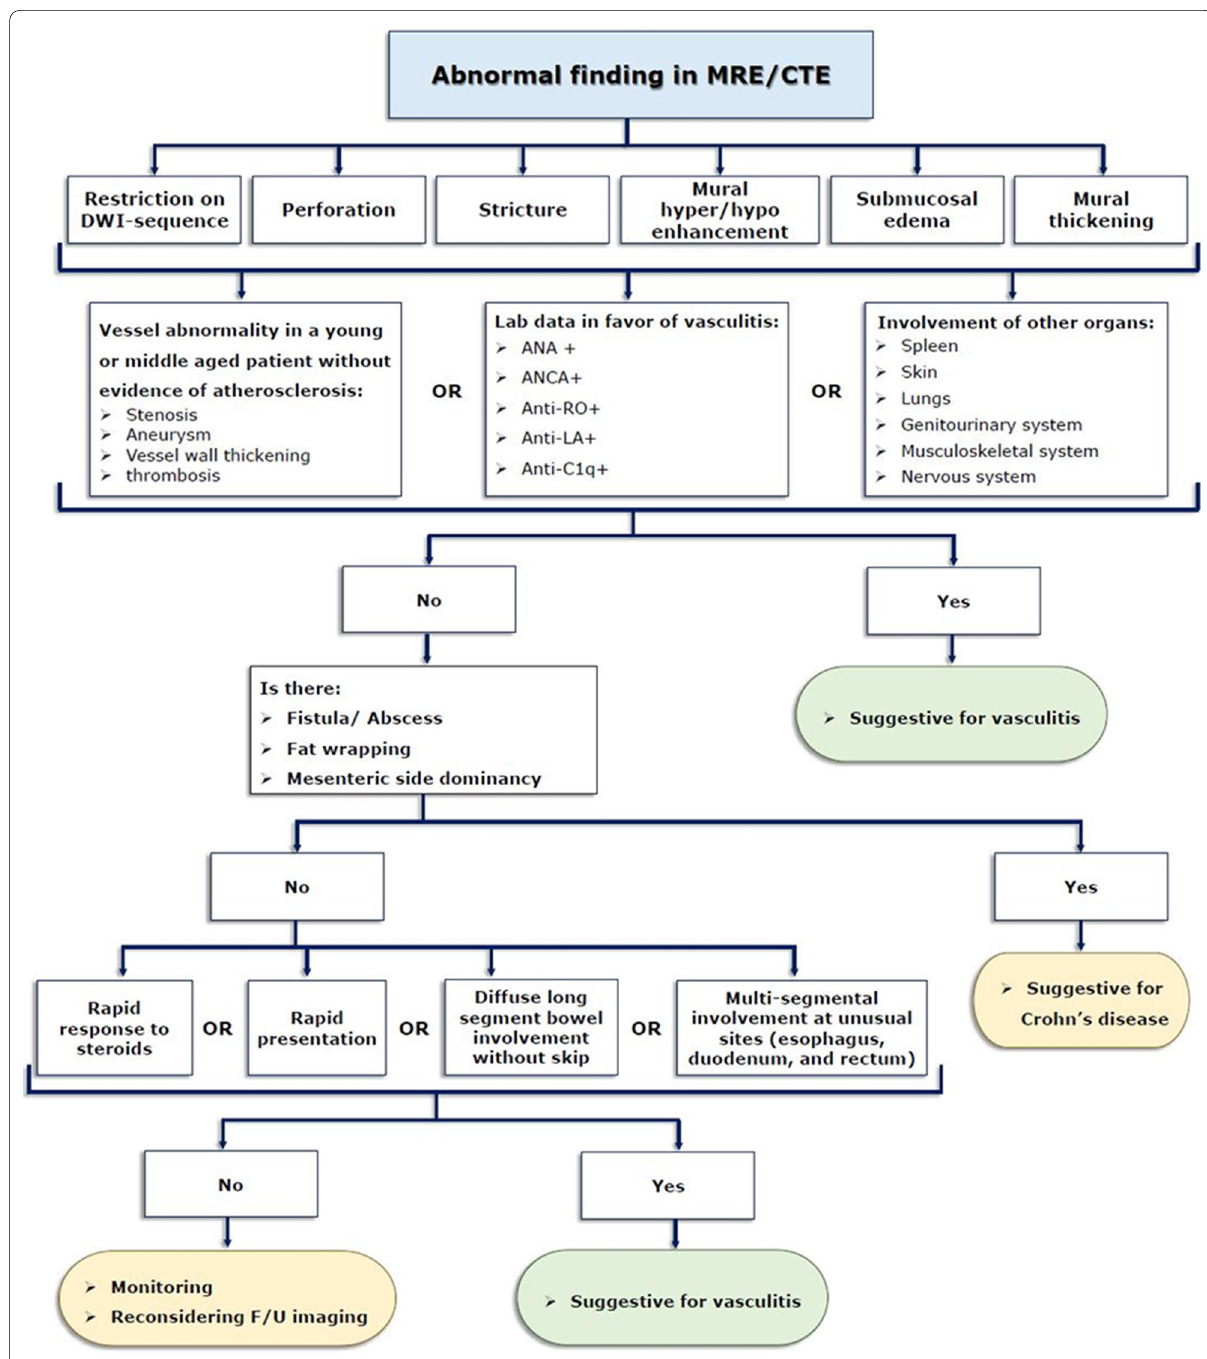
Fig. 23 A practical flowchart for potential diagnostic work up of intestinal vasculitis following MRE or